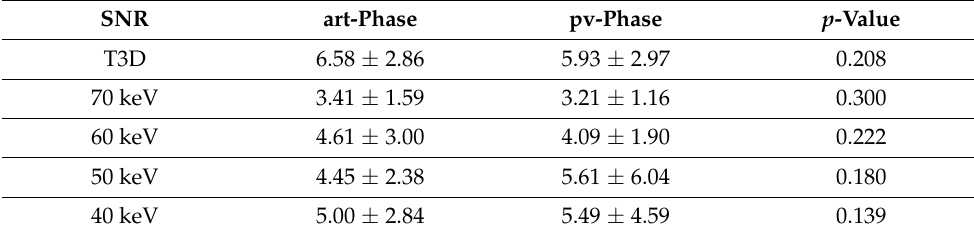
Table 5. Comparison of CNR tumor-to-liver of arterial and portal venous phases.